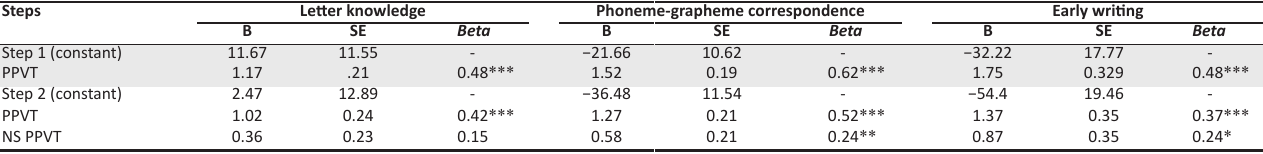
TABLE 3: Overview of regression analyses with Letter knowledge , Phoneme-Grapheme correspondences and Early writing as dependent variables and English receptive vocabulary (PPVT) and NS receptive vocabulary (NS PPVT) as predictors. Steps Letter knowledge Phoneme-grapheme